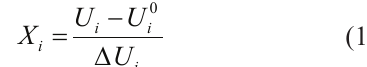
Table 1 – Codified levels for the factors in CCD Independent variables (concentration, w/v %)